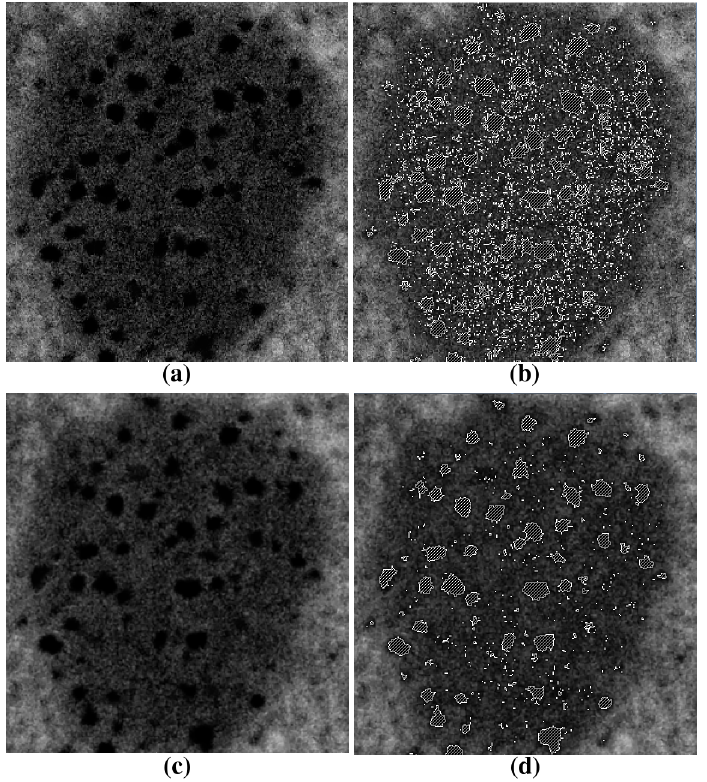
Figure 3. Segmentation of the lipid droplet. ( a ) sharp image slice and ( b ) its noisy thresholding result; ( c ) blurred slice; and ( d ) its thresholding